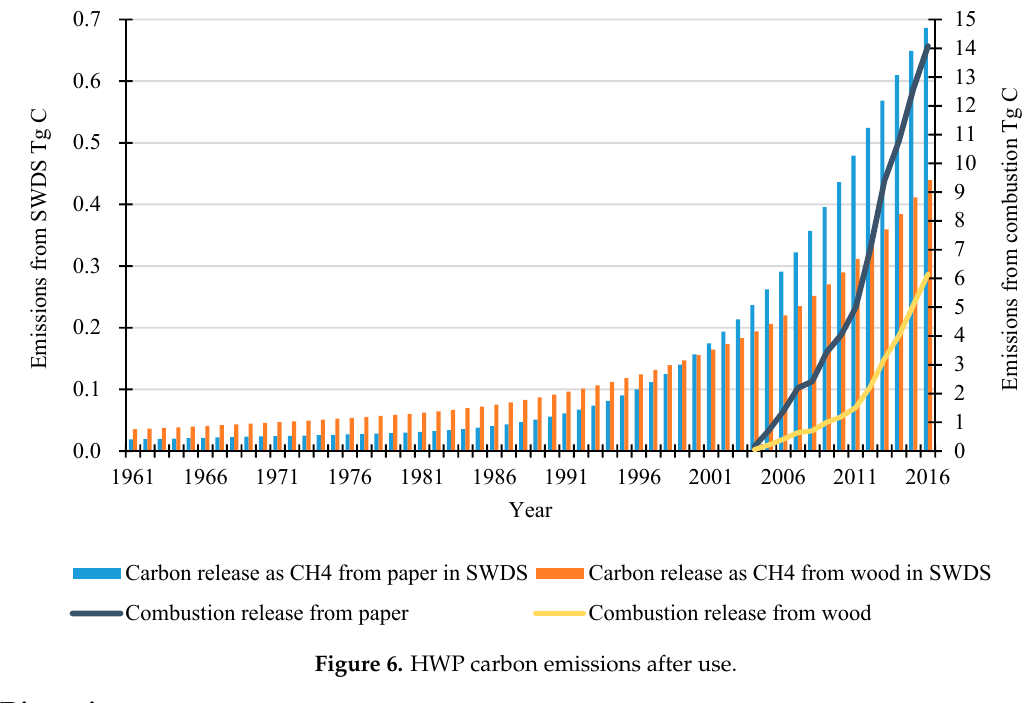
Figure 6. HWP carbon emissions after use.